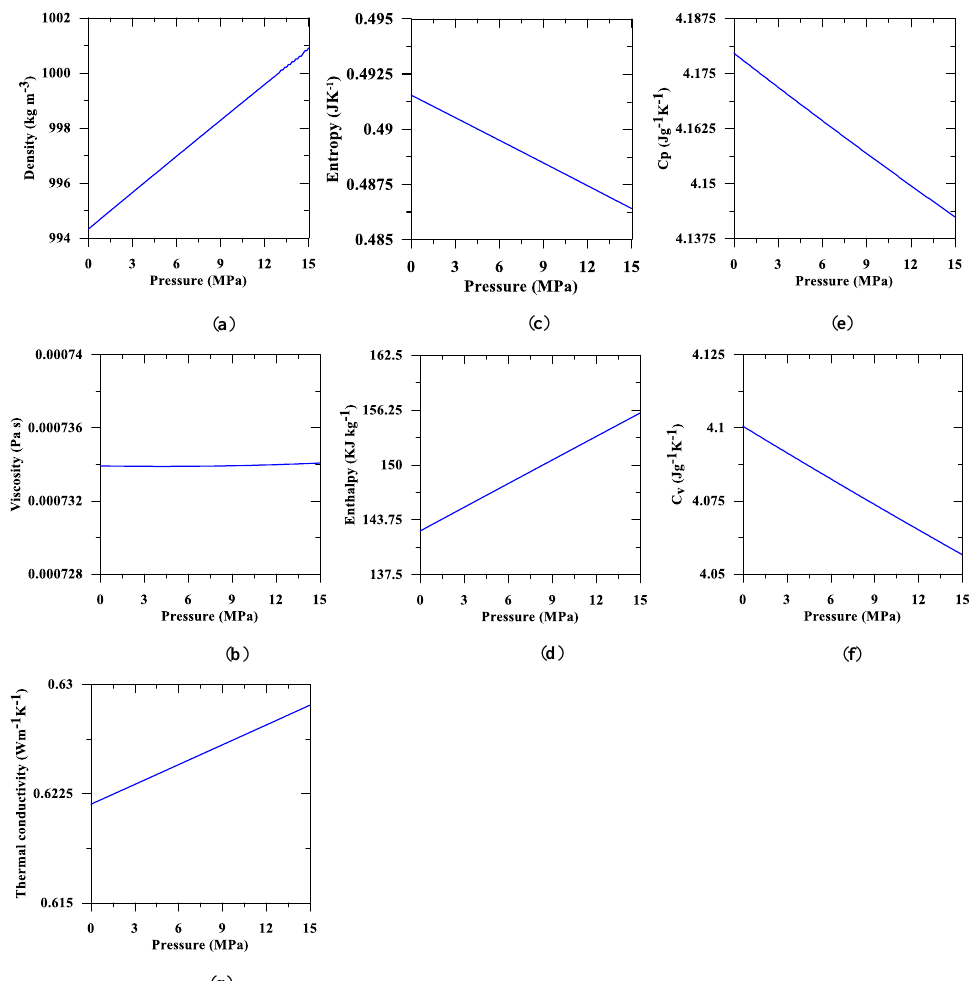
Figure A1. Properties of CO 2 at 307.15 K ( a – g ; see also CoolProp Package: Bell et al. [57] ) .